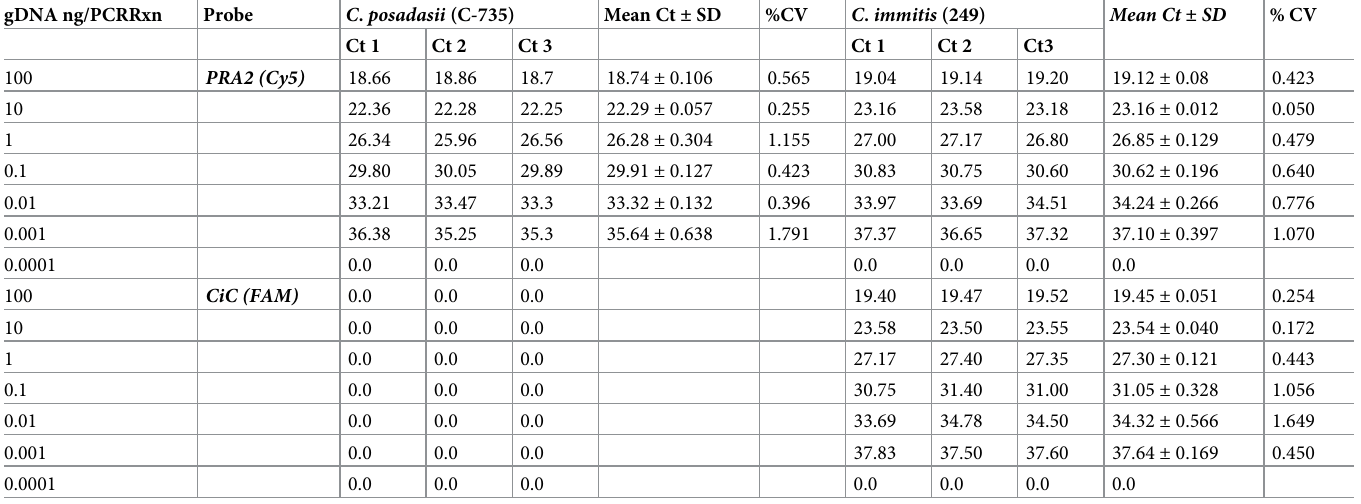
Table 2. Coccidioides duplex real-time PCR assay